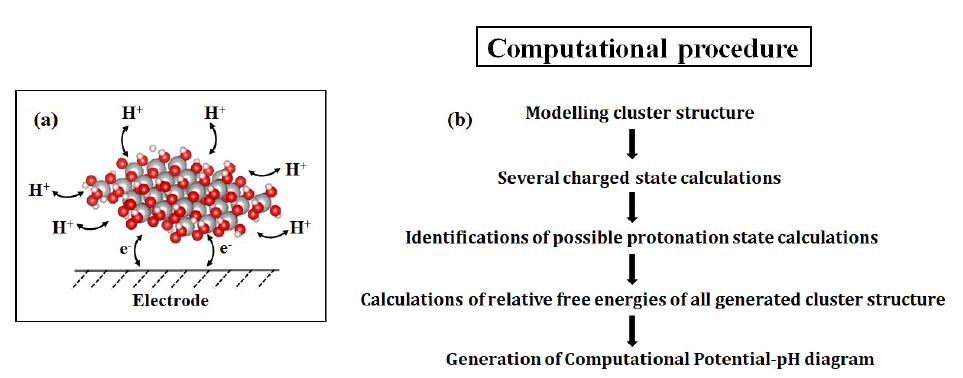
Fig. 1. – (a) Modeling of electrocatalytic materials, including the effect of potential and p H. An electrode is held for the electron transfer, and proton transfer is studied using an implicit solvation model. (b) Computational protocol for the calculations of the potential and the effect of p H of an electrocatalytic